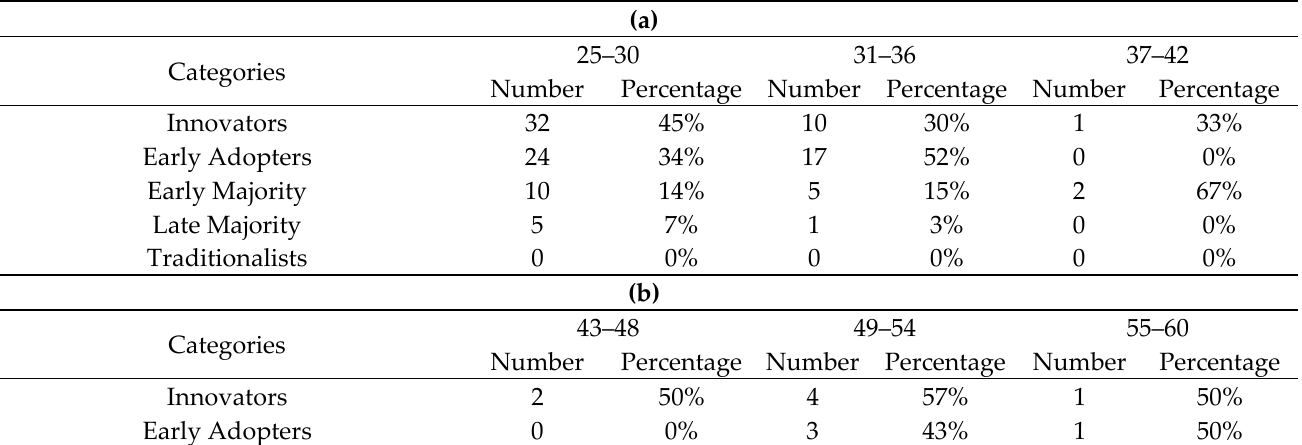
Table 9. Analysis according to